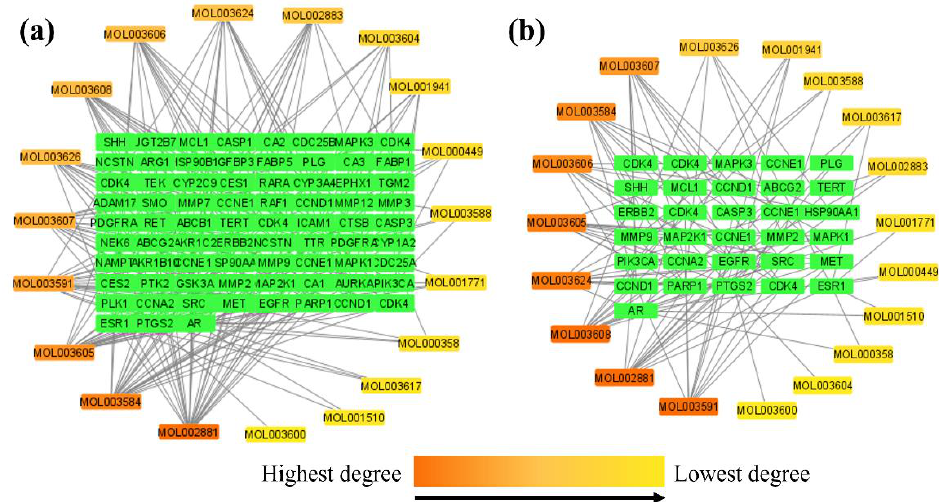
Figure 5. ( a ) Network between the 19 active phytochemicals and 67 intersecting targets. ( b ) Hub network between the 19 active phytochemicals and 25 potential anti-HCC core targets. Each node’s color denotes the degree, from red (highest) to yellow (lowest), as the node degree decreases.